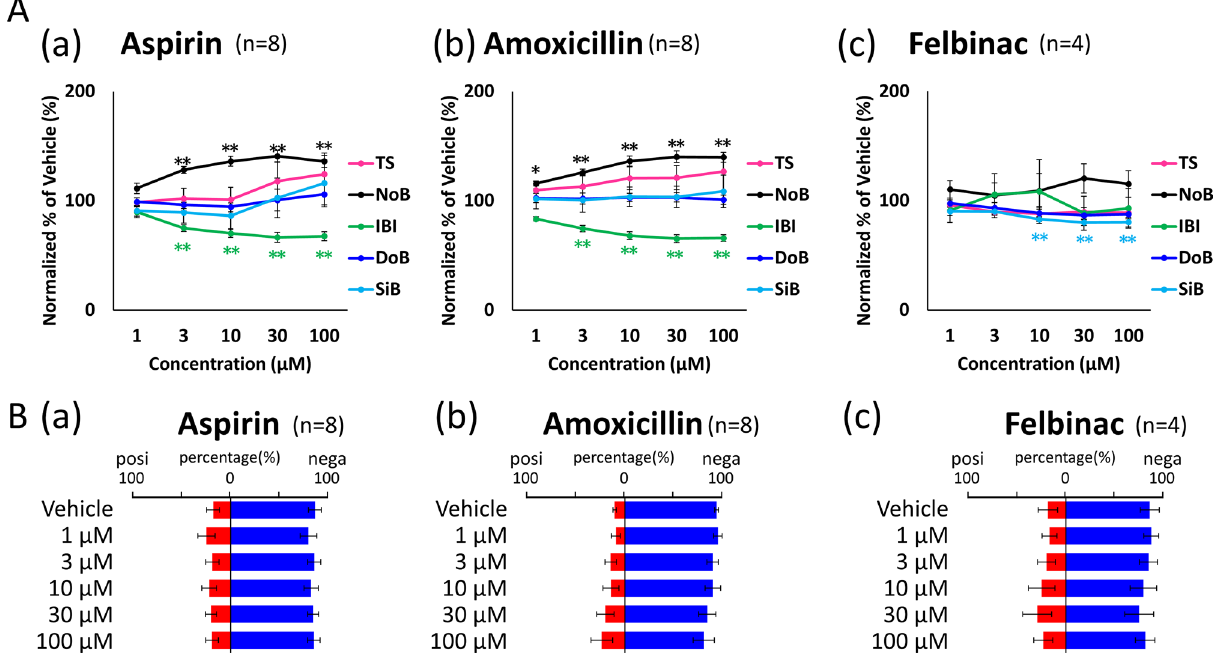
Figure 6. Prediction of seizure risk in non-training negative compounds by AI. (A) Concentration-dependent changes of 3 negative compounds in five parameters: TS (pink), NoB (black), IBI (green), DoB (blue), SiB (cyan). (a) Aspirin, (b) amoxicillin, (c) felbinac, (B) AI predicted the negative probabilities (blue bar) and seizure risk (red bar) at each concentration.